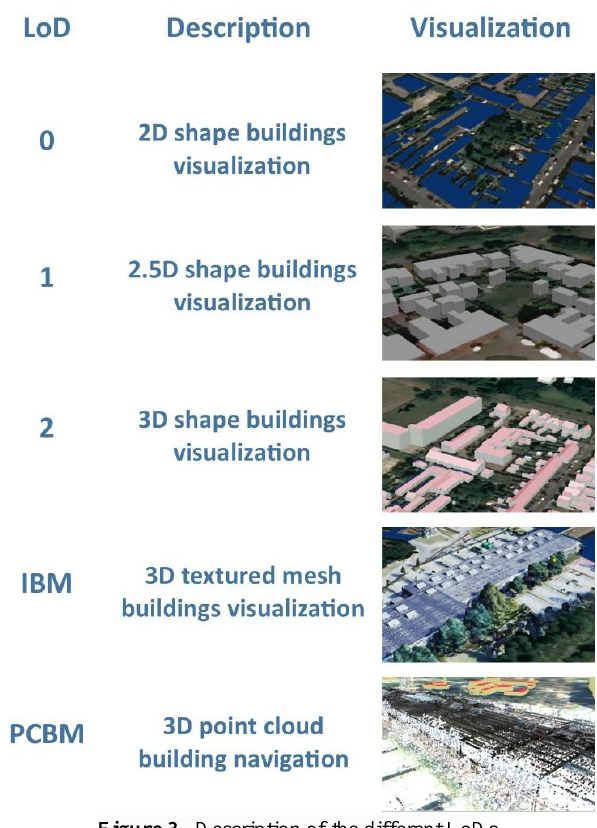
Figure 3 . Description of the different